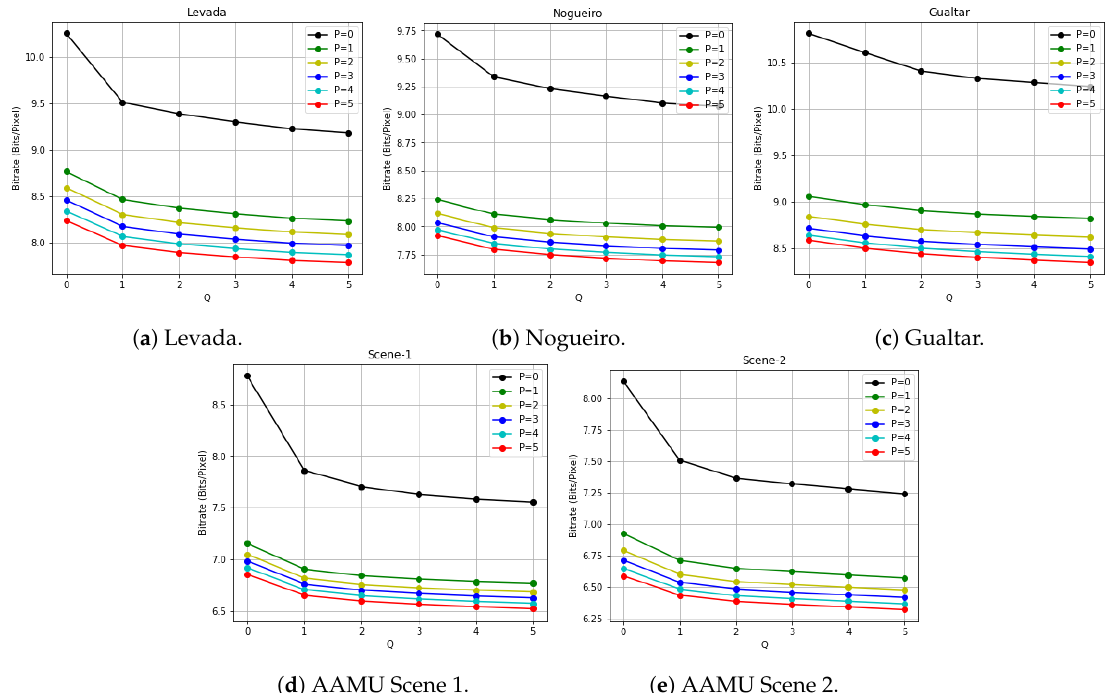
Figure 4. Conditional entropies over five datasets for different P and Q